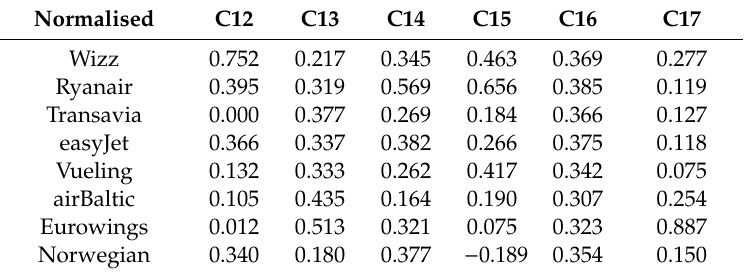
Table A7. Full calculations of the successfulness TOPSIS.